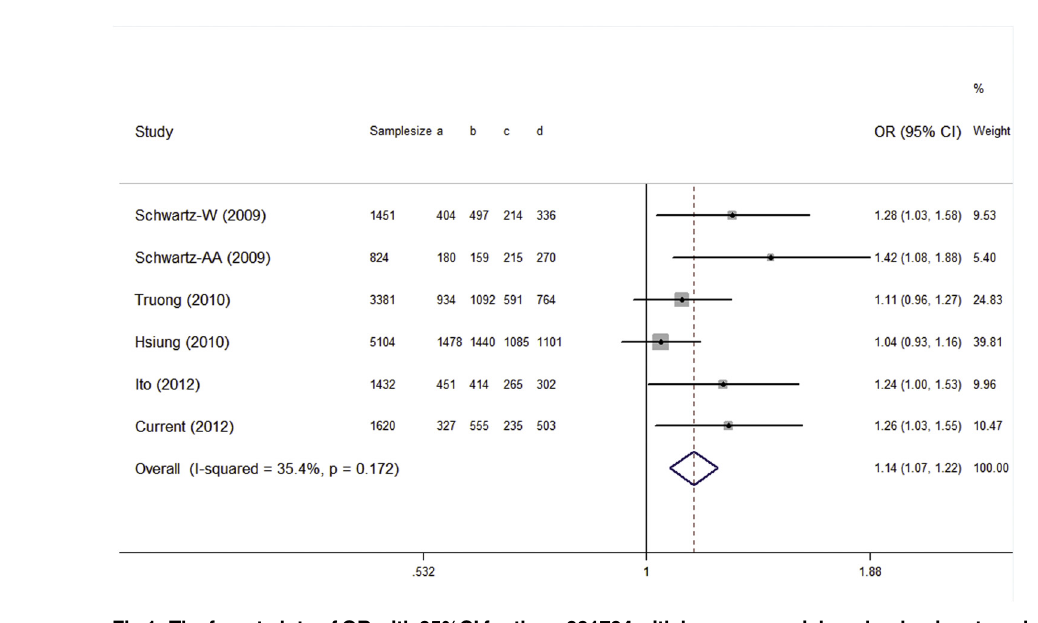
Fig 1. The forest plots of OR with 95%CI for the rs931794 with lung cancer risk under dominant model. Fixed-effects pooled OR=1.14, 95%CI = 1.07-1.22, P < 0.001; P heterogeneity =